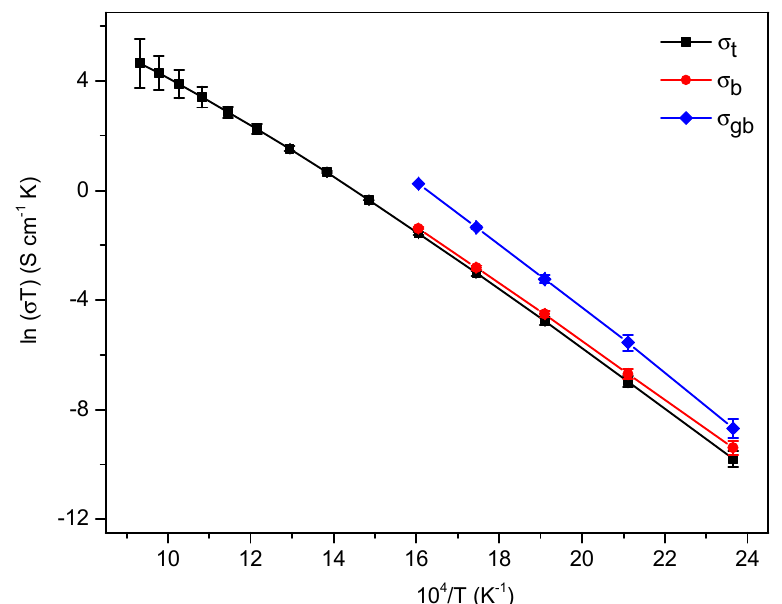
Figure 6. Arrhenius plots of total, bulk and grain boundary conductivity for Sr00.